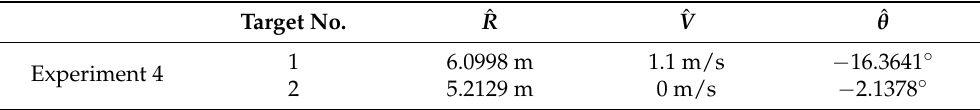
Figure 16. The estimation process of G and V . ( a ) is the targets-located blocks selection. ( b ) is the result of G and V of the experiment. Table 6. The estimated results of experiment